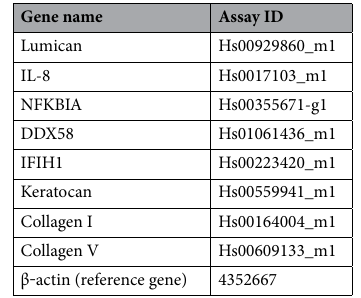
Table 3. Probes used for real ‐ time PCR from Applied Biosystems.